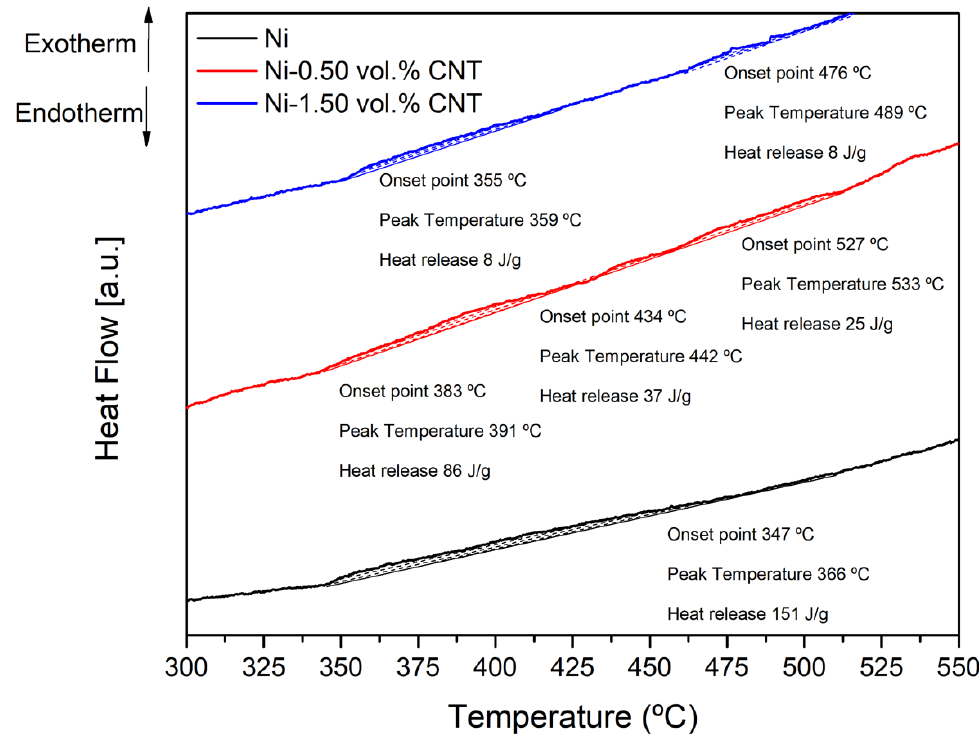
Figure 14. DSC curves of Ni, Ni-0.50 vol.% CNT and Ni-1.50 vol.% CNT nanocomposites.